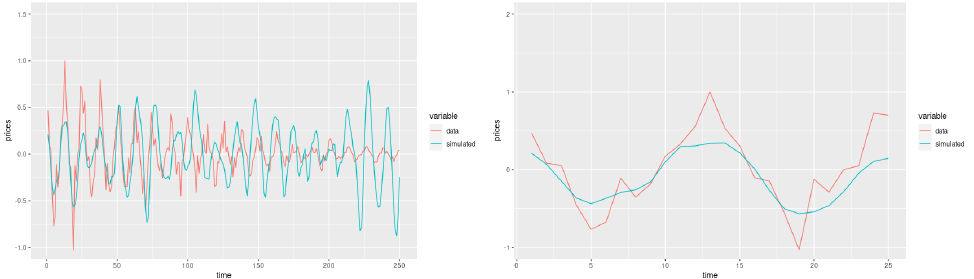
Figure 7. Price trajectories generated by the model (54) vs. the artificial data (69). On the left : the entire temporal range. On the right : the first 25 time